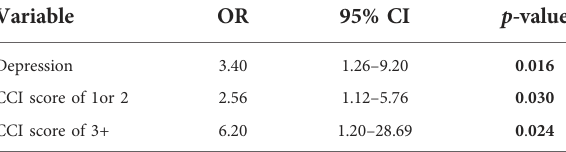
TABLE 5 Multivariate logistic analysis for risk factors associated with dissatisfaction.